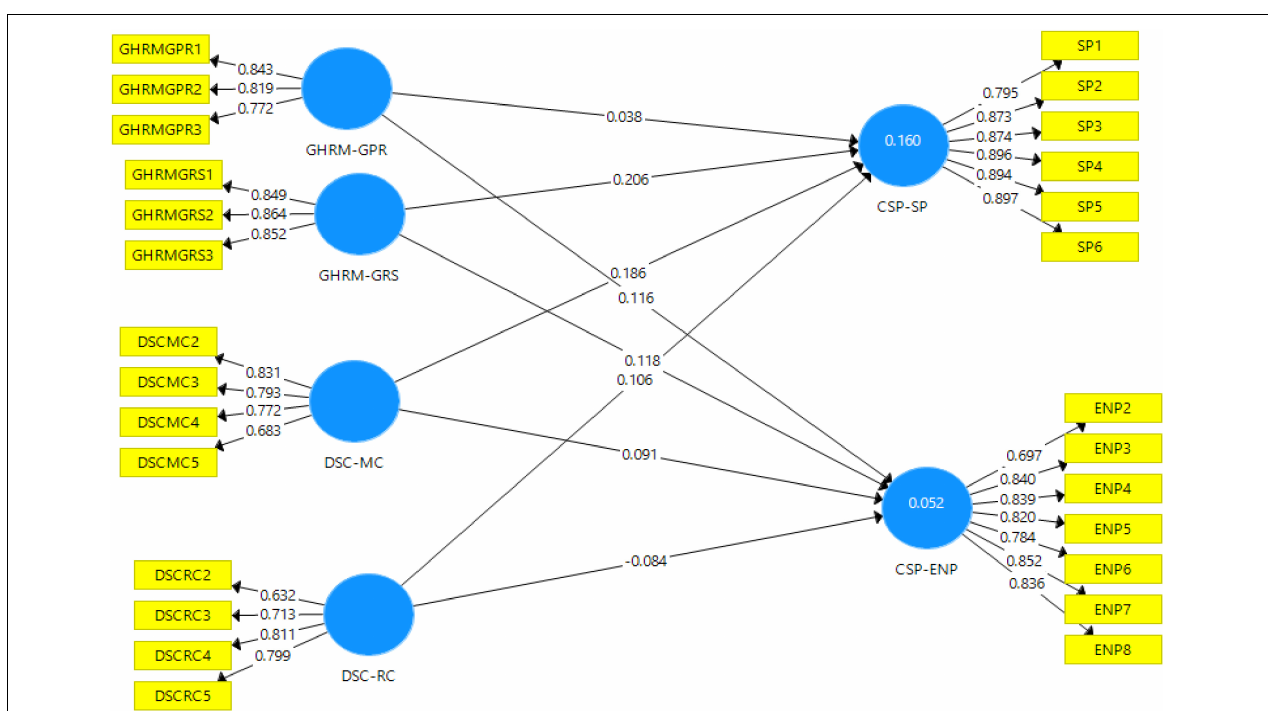
FIGURE 3 | Model-partial least squares (PLS) quality criteria overview.